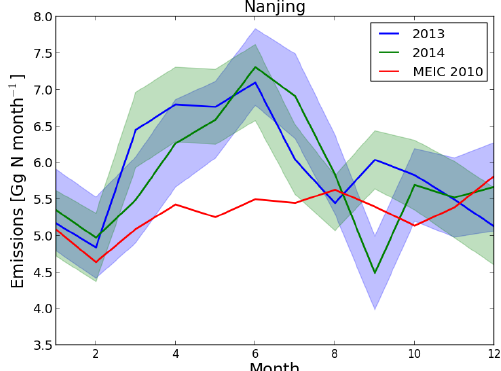
Figure 10. The monthly NO x emission estimates by DECSO in Nanjing for 2013 (blue line) and 2014 (green line) and the monthly NO x emission of the MEIC inventory of 2010 (red line). The shade areas show the error of the mean NO x emission estimates from